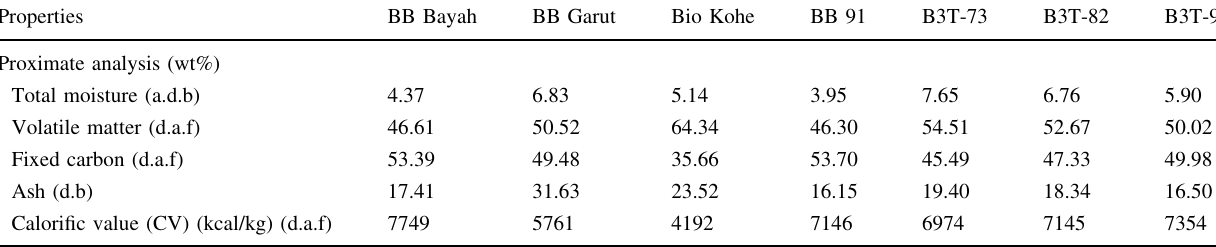
Table 2 Ultimate analysis of raw coal, biomass waste and bio-coal briquettes Properties BB Bayah BB